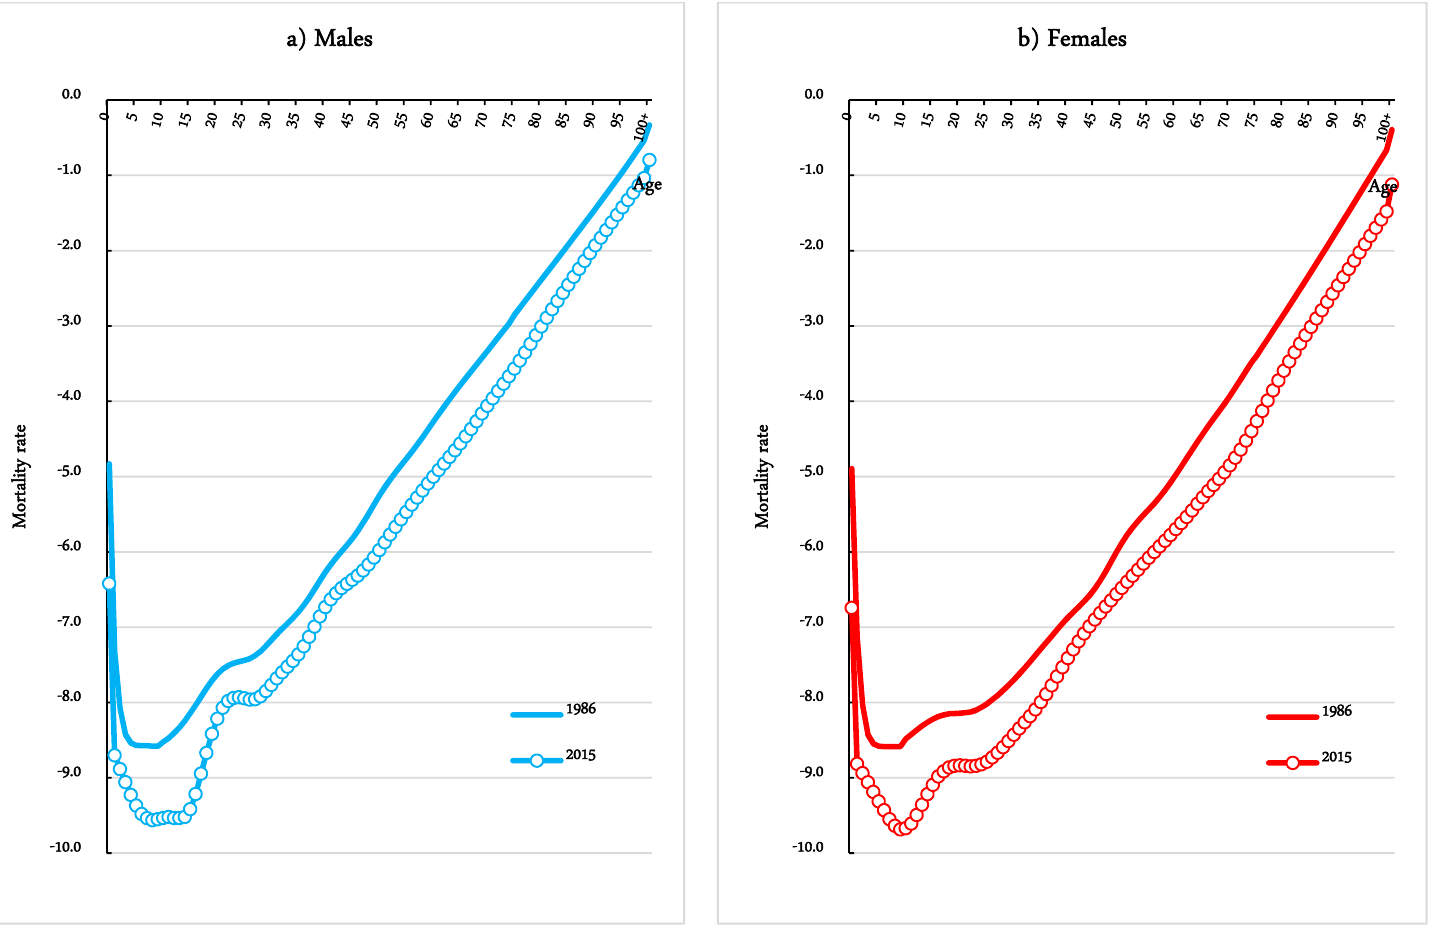
Figure A1. Mortality change in Hong Kong between 1986 and 2015: ( a ) Males and ( b ) Females.